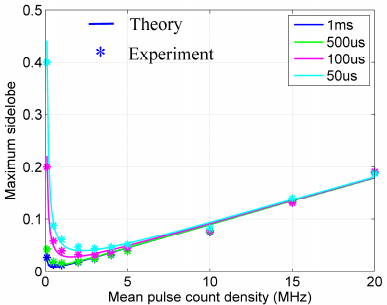
Figure 8. Theoretical and experimental results of the normalized maximum side-lobe.